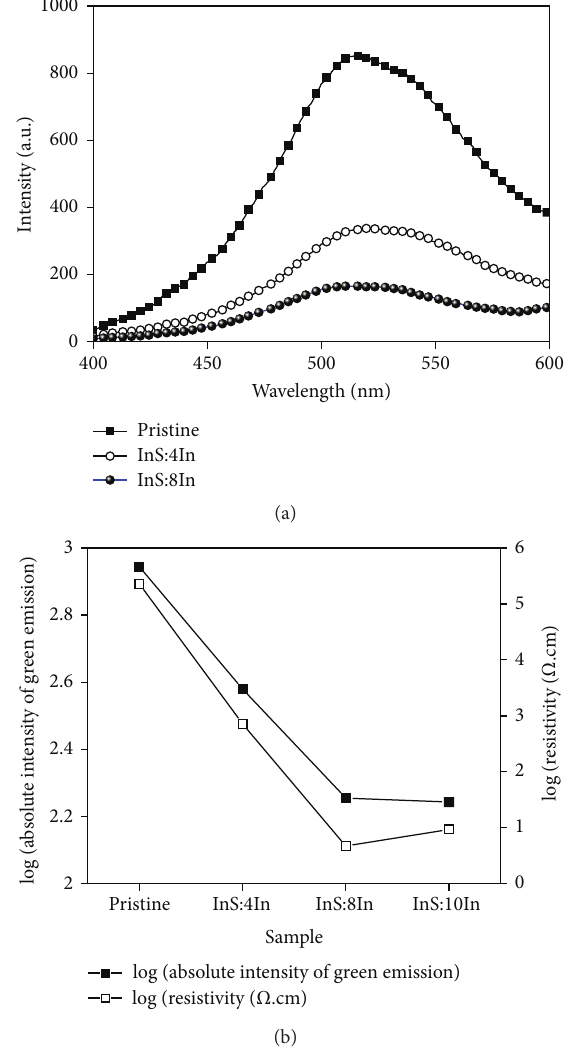
Figure 8: (a) Variation in intensity of green emission in the PL spectrum of In 2 S 3 thin films on indium incorporation. (b) Variation of absolute intensity of green emission and resistivity of In 2 S 3 thin films on indium incorporation drawn in a log